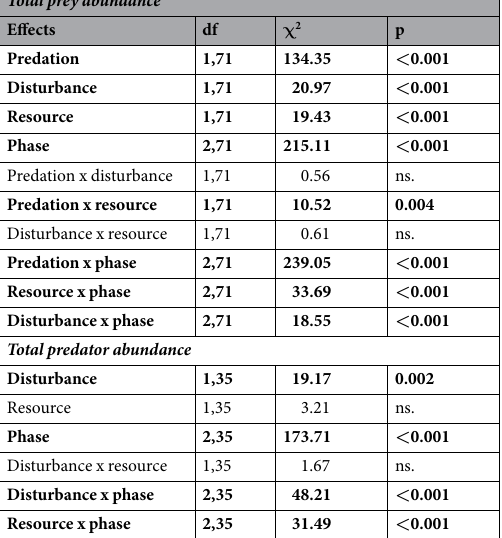
Table 1. Fixed effects in linear mixed-effects models of prey and predator abundance response to predation and disturbance. Df is degrees of freedom, χ 2 and p values were derived from the parametric bootstrap. Significant effects are highlighted in bold.